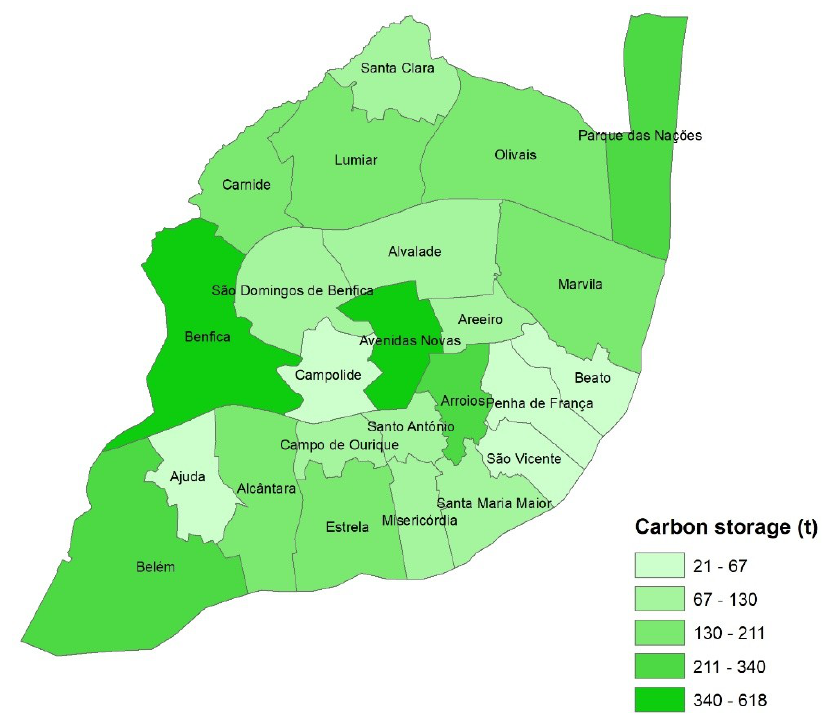
Figure 5. Carbon storage (t) by parish in the city of Lisbon.